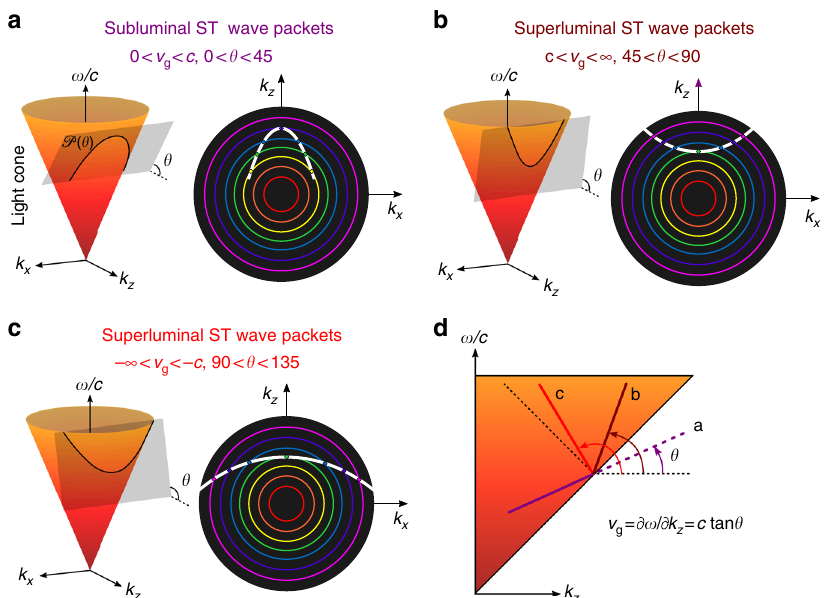
Fig. 1 Spatio-temporal spectral engineering for arbitrary group velocity control. a – c Conic-section trajectories at the intersection of the free space light-cone with a spectral hyperplane Pð θ Þ are spatio-temporal spectral loci of space-time (ST) wave packets with tunable group velocities v g in free space: a subluminal, b superluminal, and c negative-superluminal v g . For each case we plot the projection of the spatio-temporal spectrum onto the ( k x , k z ) plane restricted to k z > 0 (white curve). d Projections of the spatio-temporal spectra from ( a – c ) onto the ð k z ; ω c Þ plane. The slope of each projection determines the group velocity of each ST wave packet along the axial coordinate z , v g = c tan